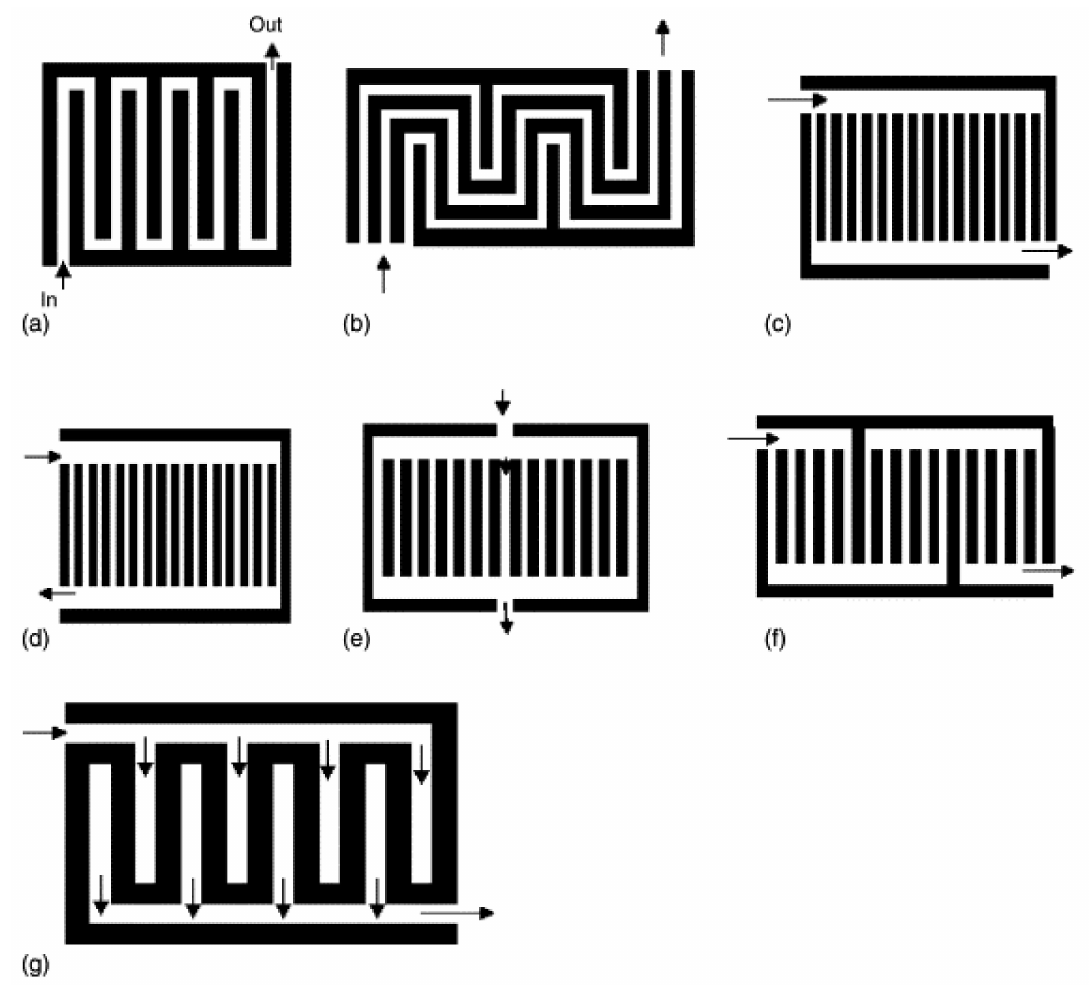
Figure 8. Bipolar geometry illustrations: ( a ) single serpentine design; ( b ) multiple serpentine de- sign; ( c ) single/parallel Z- design; ( d ) single/parallel Z- design; ( e ) symmetrical design; ( f ) discon- tinuous design; ( g ) interdigitated channeling (Reprinted with permission from Ref. [82], license No.